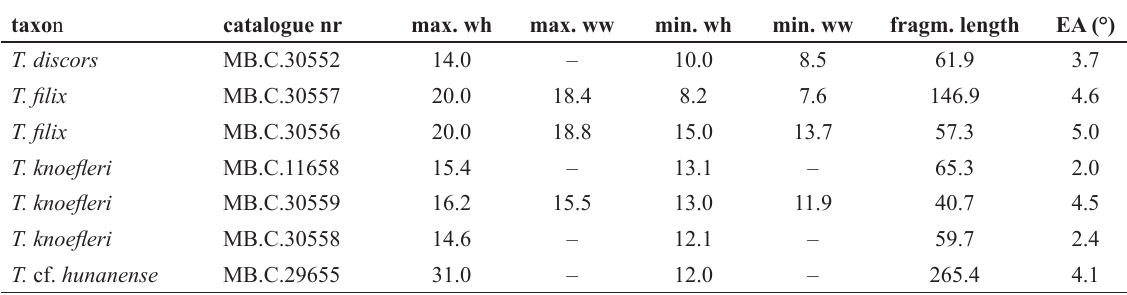
Table 13. Conch measurements (in mm), and expansion rates of uncoiled conch parts of Trilacinoceras Sweet, 1958.